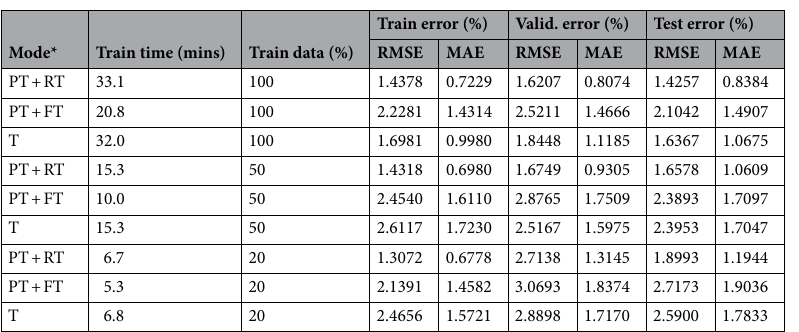
Mode* Train time (mins) Train data